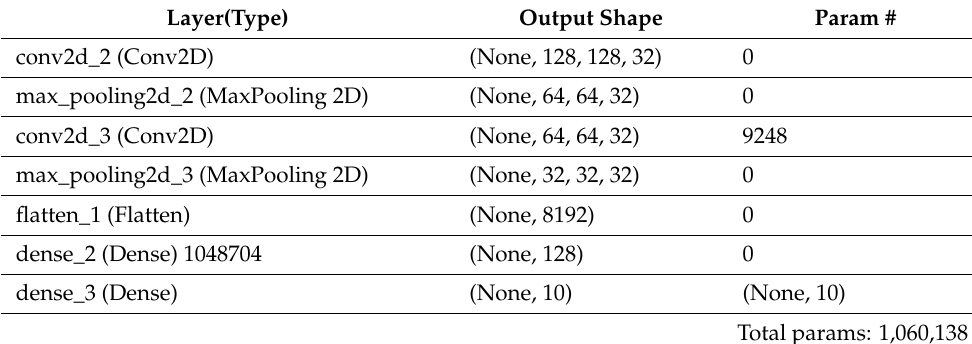
Table 1. Structure of Convolutional Neural